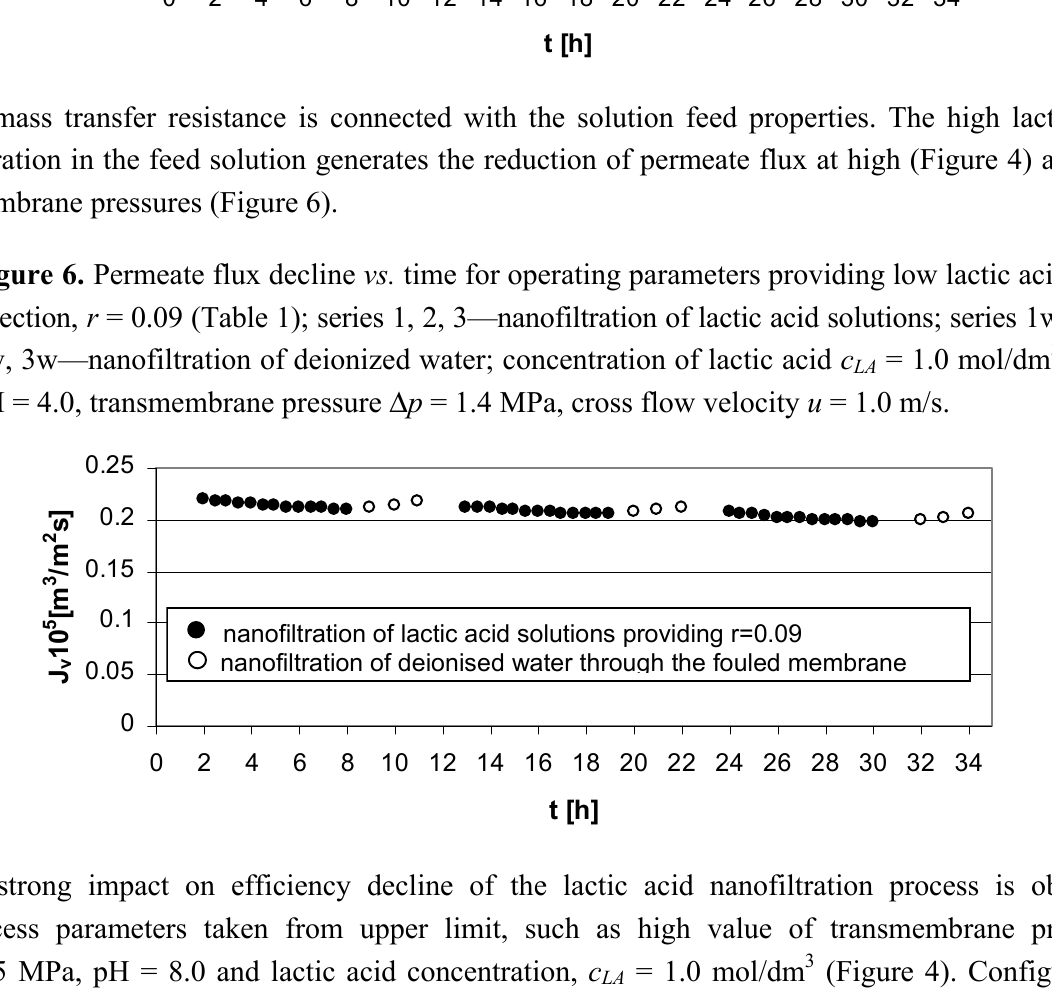
= 0.02 mol/dm 3 , LA